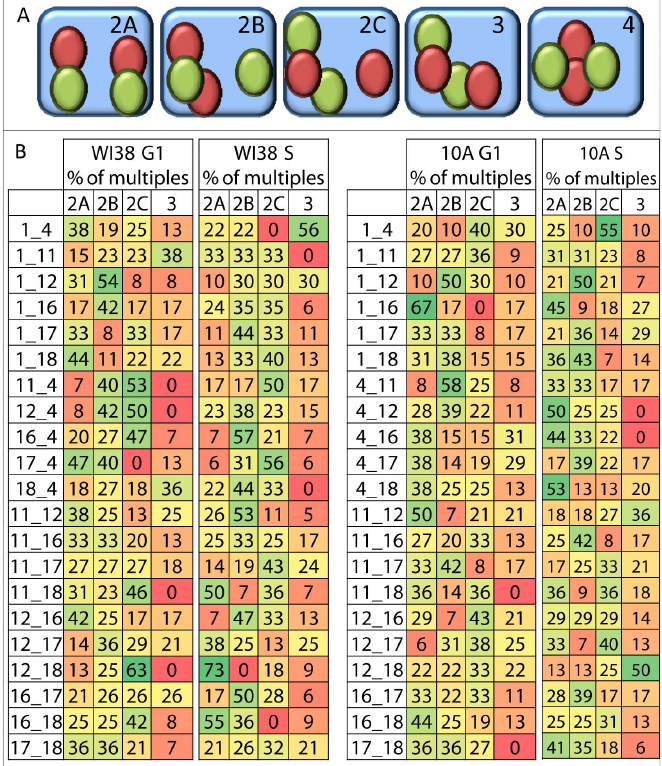
Figure 4. Patterns of multiple interactions of CT pairs. ( A ) Categories of multiple interactions of CT pairs for 2, 3 and 4 interactions are illustrated; ( B ) the percent of multiple interactions that are type 2a, 2b, 3 interactions were calculated and are shown for WI38 and 10A. Green depicts the highest levels of interaction between CT pairs and red the lowest. Chi-square test indicates many significant differences between 2A–2C between CT pairs across the cell cycle and between cell types.